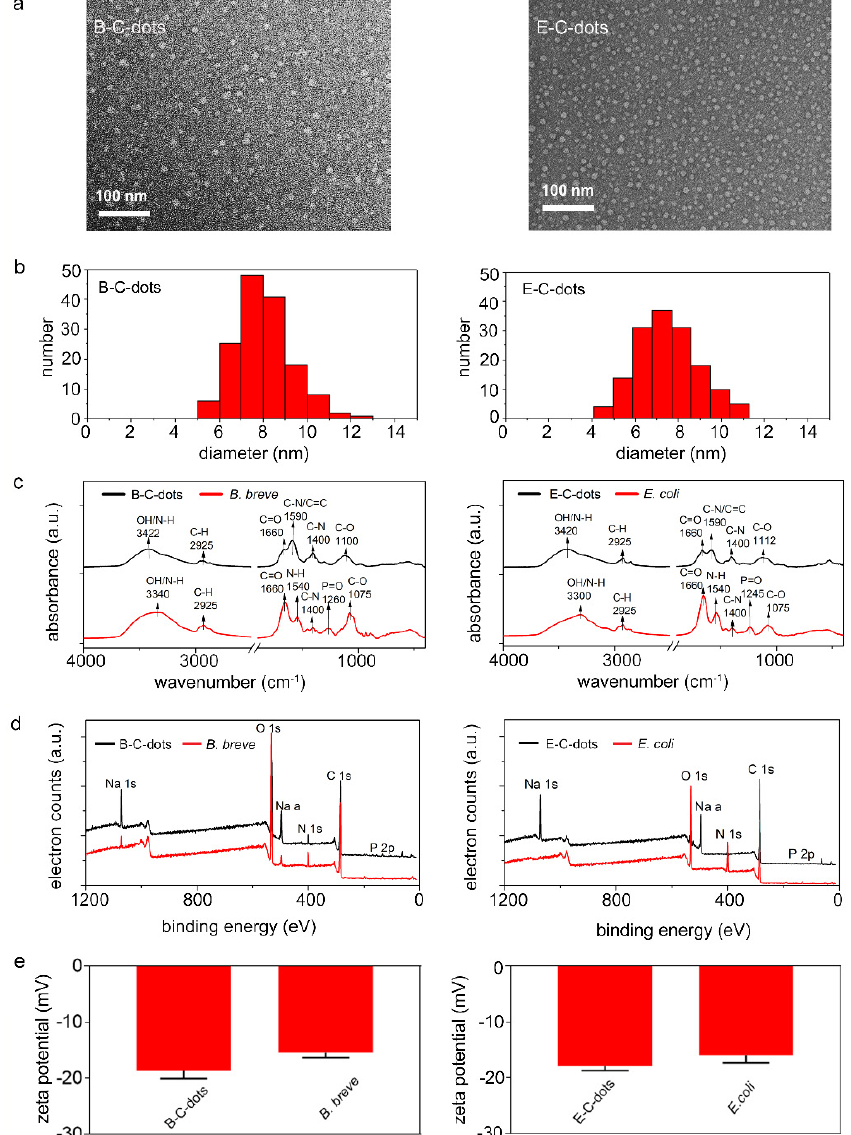
Figure 1. Physico-chemical characterization of C-dots and bacteria used for their hydrothermal carbonization. ( a ) TEM micrographs of C-dots derived from B. breve ATCC 15700 (B-C-dots) and E. coli ATCC 25922 (E-C-dots). ( b ) Diameter distributions of B-C- and E-C-dots as derived from TEM micrographs. Each distribution includes 150 C-dots. ( c ) FTIR spectra of B. breve and B-C-dots, E. coli and E-C-dots. Spectra have been baseline adjusted using Spectragryph software. ( d ) XPS spectra of B-C-dots and B. breve , E-C-dots and E. coli . ( e ) Zeta potentials of B-C-dots and B. breve , E-C-dots and E. coli were measured in 10 mM potassium phosphate (pH 7.4). Data are averages ± standard deviations over triplicate experiments with separately prepared nanoparticles and different bacterial cultures.